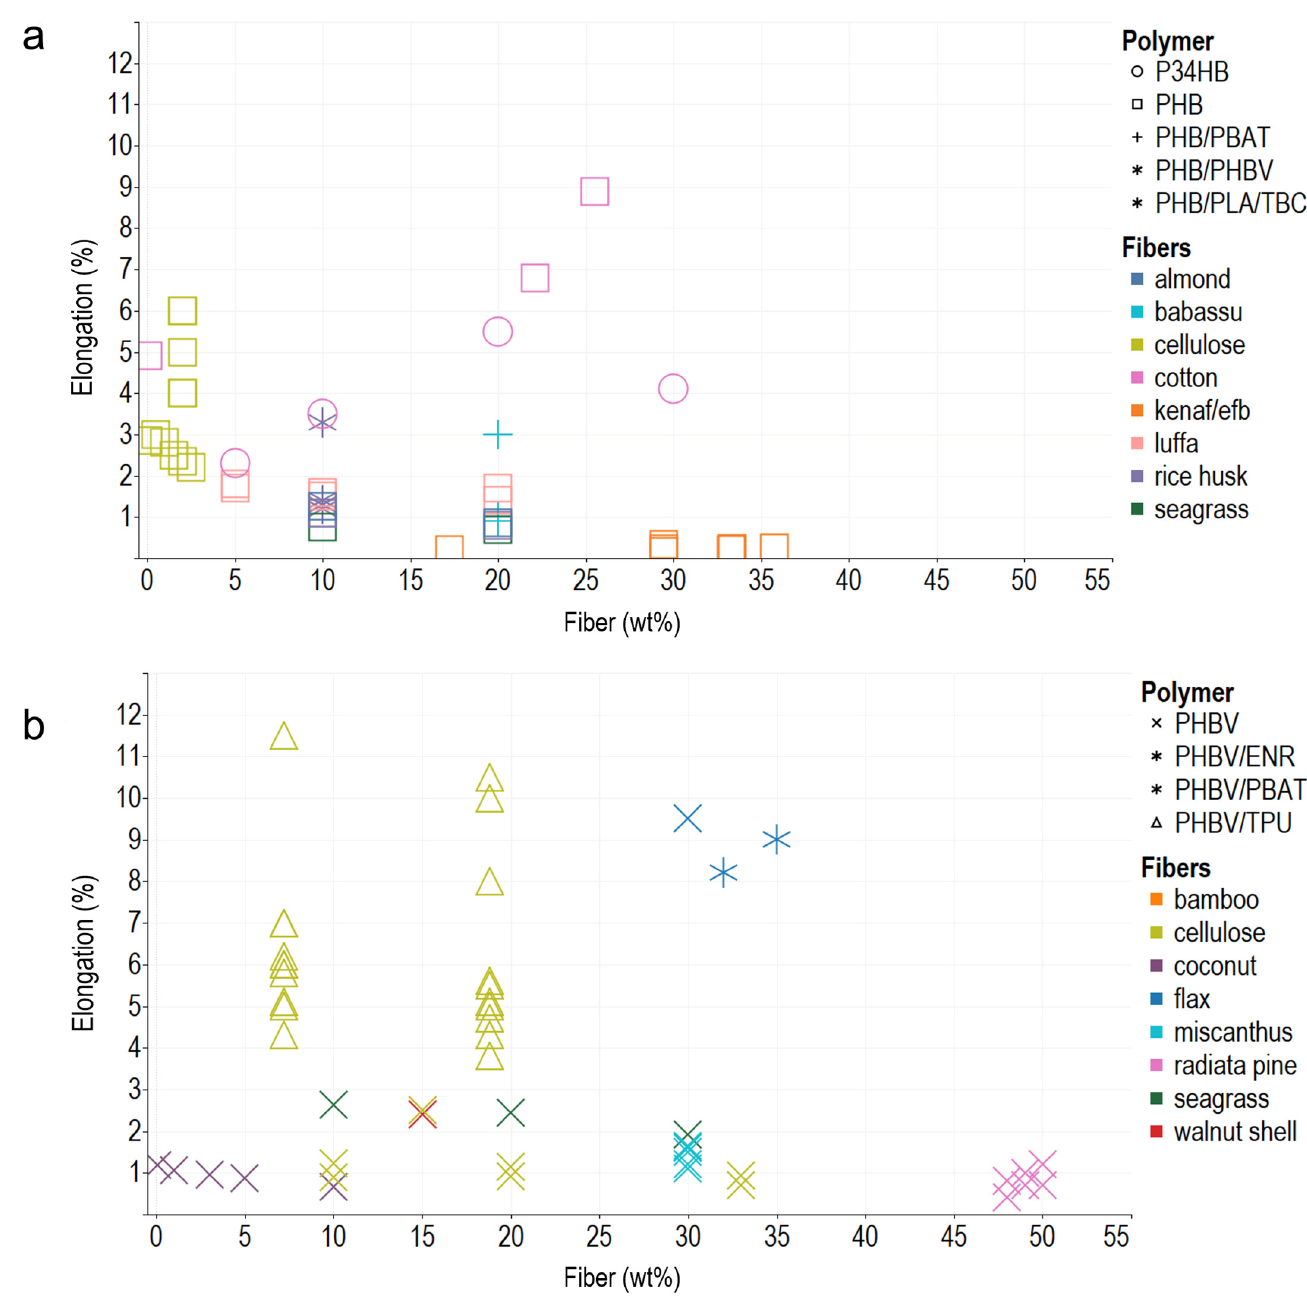
Figure 3. Elongation at break of PHA–fiber composites. ( a ) PHB and its blends with PBAT, PHBV, PLA, and TBC. ( b ) PHBV and its blends with ENR, PBAT, and TPU. The colors refer to the fiber type (fillers), and the shapes refer to polymer types (matrix).